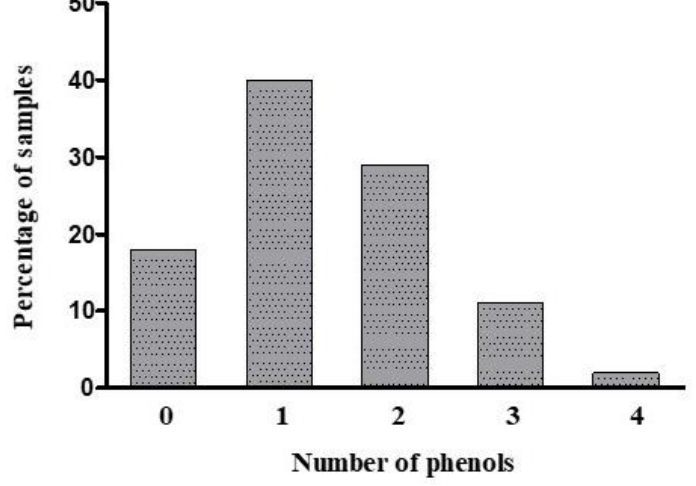
Figure 2. Co-occurrence of the target phenols in the 776 DDSF samples.